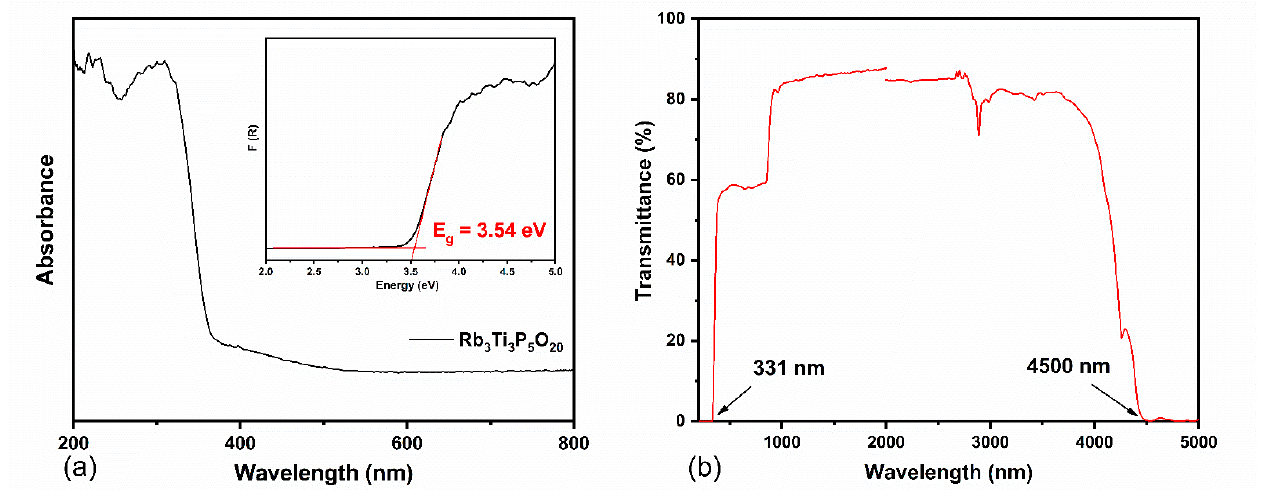
Figure 5. ( a ) UV-Vis diffuse reflectance spectra of Rb 3 Ti 3 P 5 O 20 crystal. The inset displays the experimental band gap; ( b ) UV-vis and IR transmission spectra of the Rb 3 Ti 3 P 5 O 20 crystal.